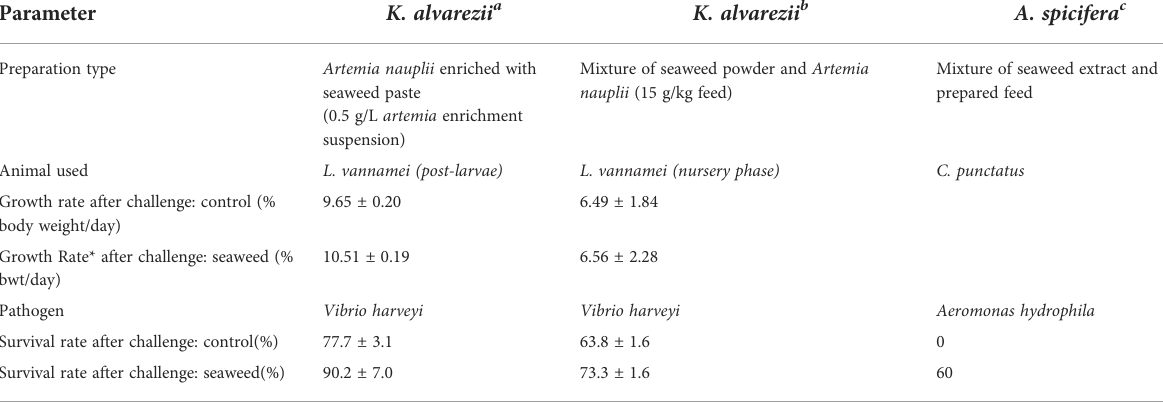
TABLE 3 Overview of aquaculture growth and pathogen challenge